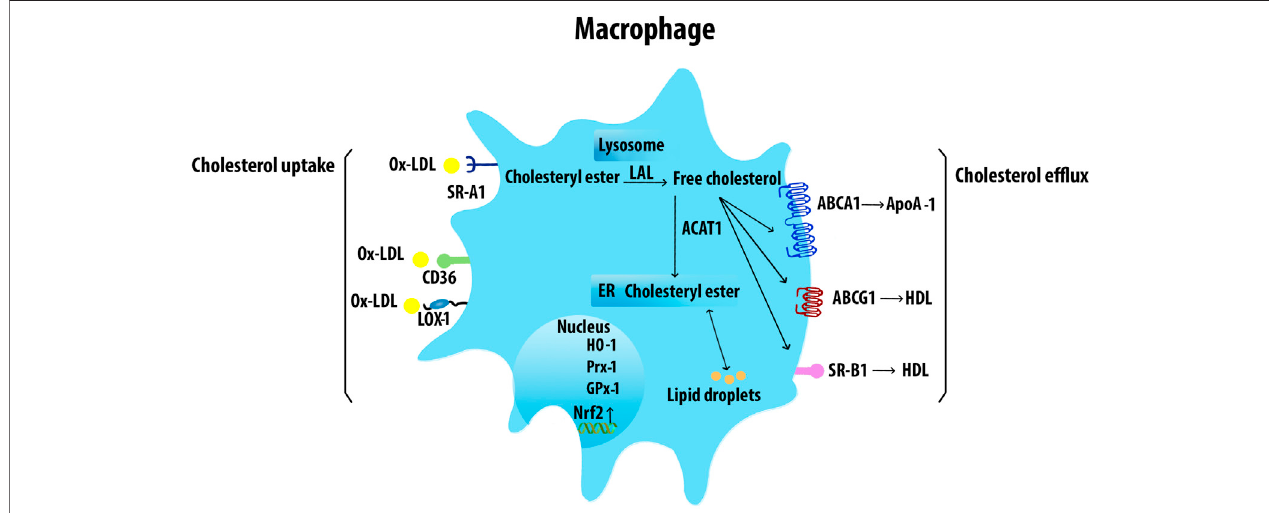
FIGURE 4 | Macrophage cholesterol uptake and ef fl ux. M φ s uptake VLDL and Ox-LDL via SRs including SR-A1, CD36, and LOX-1. The internalized LDL is esteri fi ed by acetyl-coenzyme A acetyltransferases and stored in lipid droplets. The ester group is removed from cholesteryl by neutral cholesteryl ester hydrolase through lysosomal acid lipase (LAL) to release FC. ABCA1 transporter mediates the FC ef fl ux from M φ s with ApoA-1. ABCG1 and SR-B1 also ef fl ux FC to mature HDL. Acetyl-CoA acetyltransferase 1